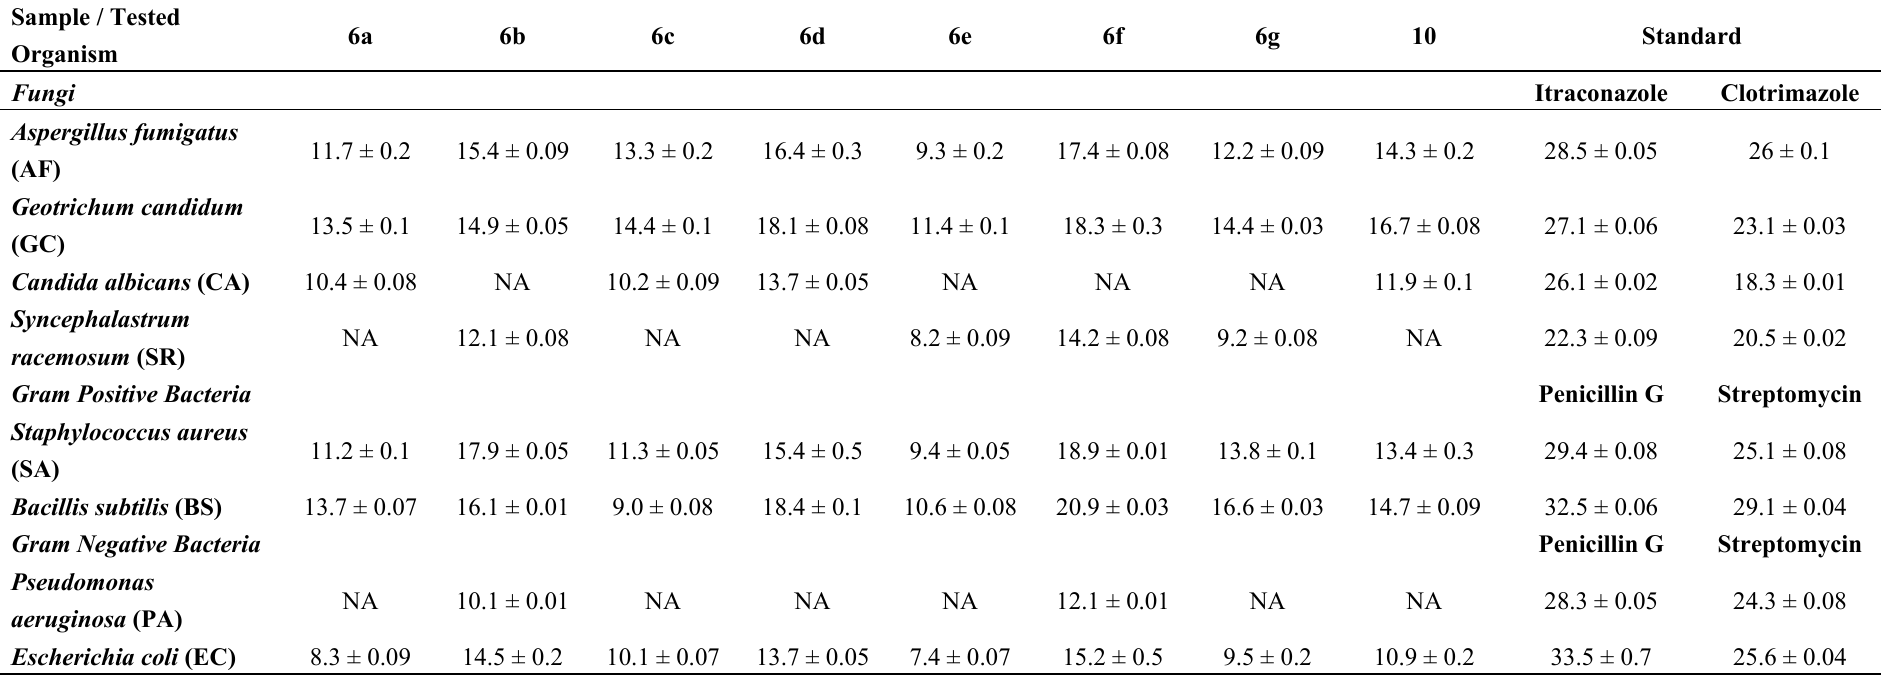
Table 1. Antibacterial and antifungal activities of the synthesized compounds ( 6a–g ) and 10